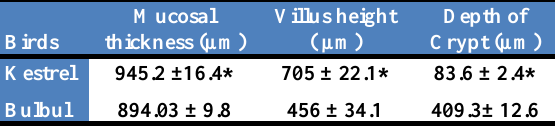
Table, 6: Mucosal thickness, villus height, depth of Crypt of ileum in kestrel and bulbul.